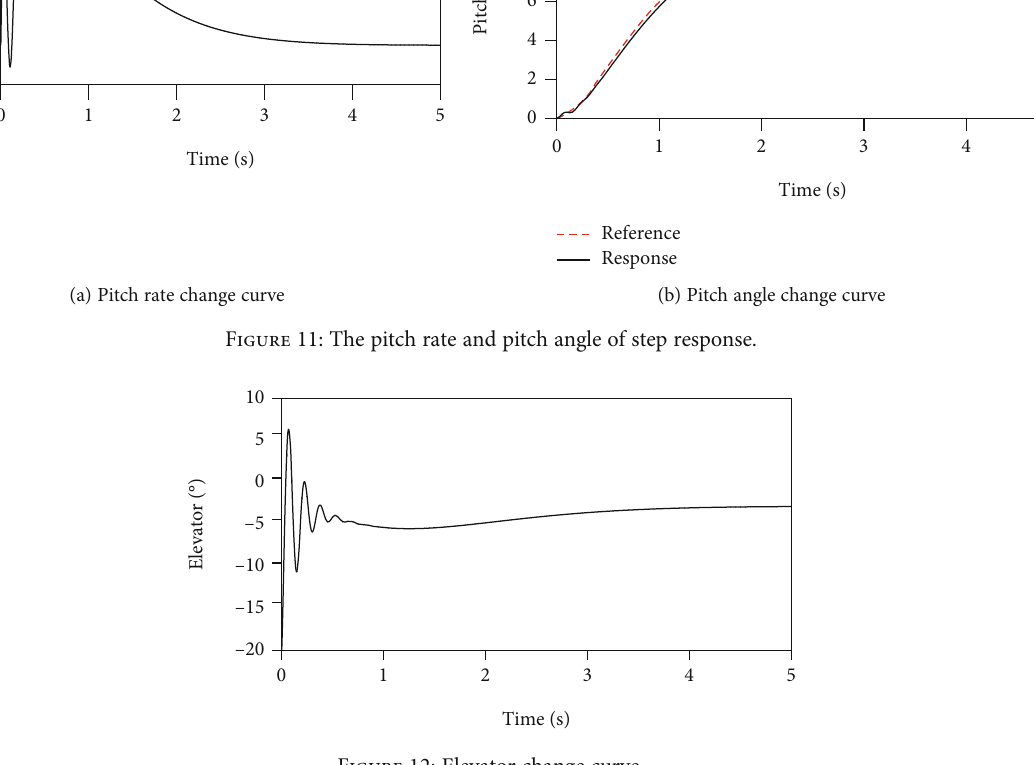
Figure 12: Elevator change